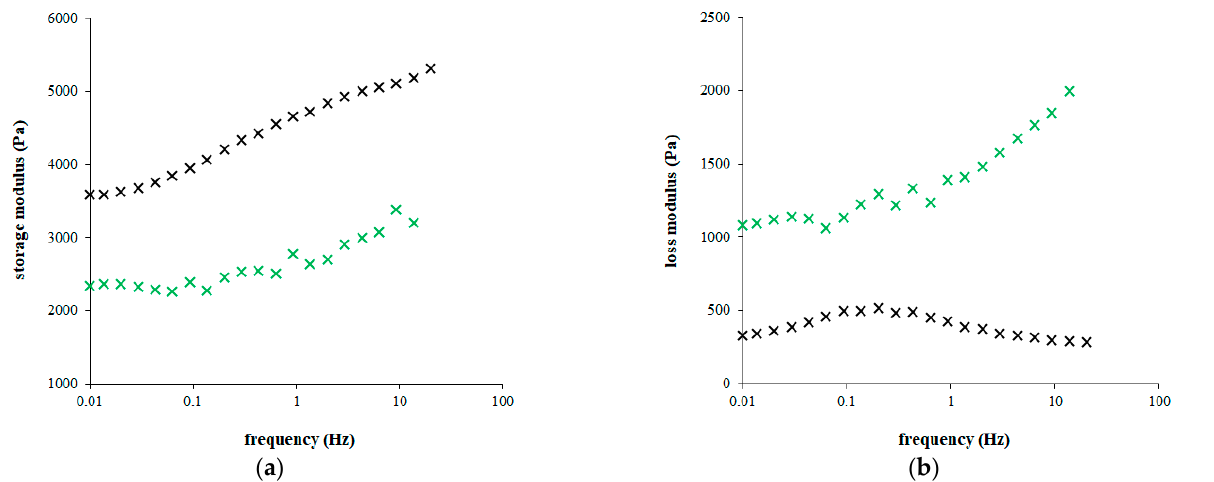
Figure 5. Storage modulus ( a ) and loss modulus ( b ) measured for pure agarose hydrogel (black) and hydrogel enriched by chitosan (1 mg g − 1 ; green). Measurement was realized in linear viscoelastic region (strain 0.1 %).